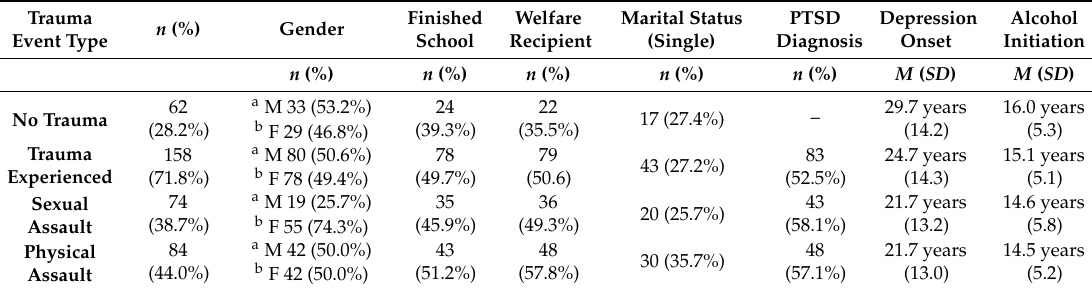
Table 1. Demographic Characteristics for No Trauma, Trauma Experienced, Sexual Assault and Physical Assault Groupings ( n =